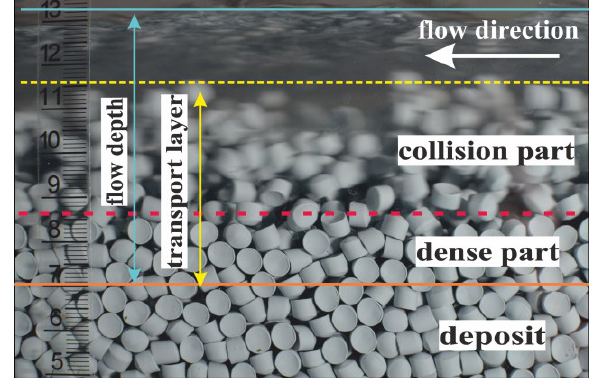
Fig. 1. Layered flow condition in flow transporting the FA60 plastic grains.